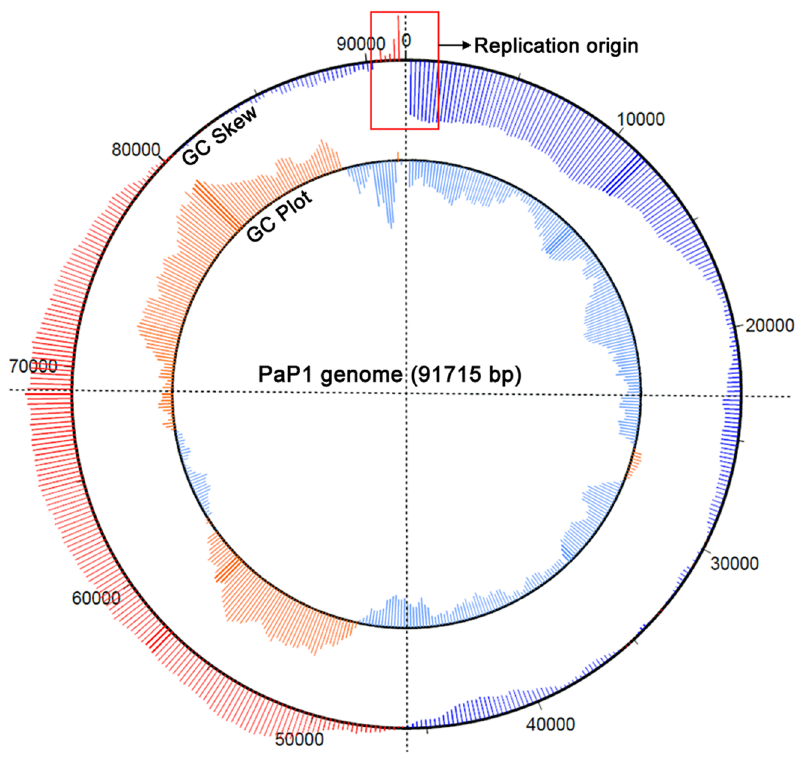
Figure 3. Circular conformation of GC skew and GC plot of the PaP1 genome. The GC skew is calculated as (G-C)/(G + C) and the GC plot shows GC% content plot. The outer circle represents the GC skew (red for positive and blue for negative); the inner circle represents the GC plot (pink for above-average and powder blue for below-average). The red pane indicates the putative replication origin of the PaP1 genome.